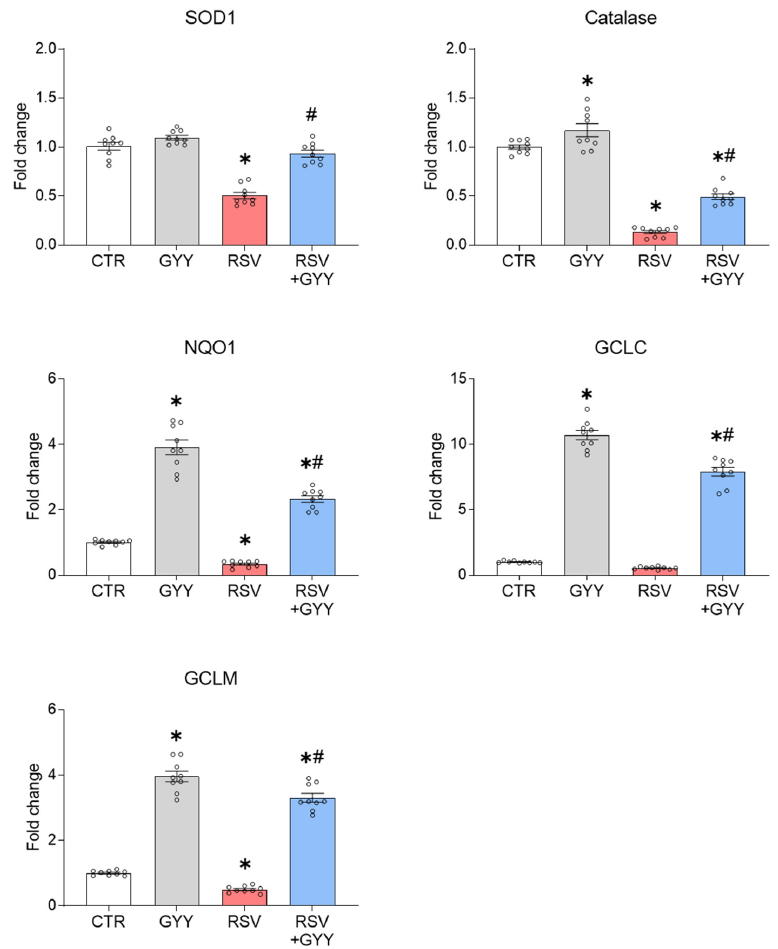
Figure 2. H 2 S donor GYY4137 rescues NRF2-dependent gene expression in RSV infection. SAECs uninfected and infected with RSV were treated with 5 mM GYY4137 and harvested 18 hpi to prepare total RNA. SOD1, catalase, NQO1, GCLC, and GCLM gene expression were quantified by RT-qPCR. Graphs show combined data from three independent experiments expressed as mean ± SEM. The results were analyzed by two-way ANOVA followed by Tukey’s test (* p < 0.05 vs. CTR; # p < 0.05 vs. RSV).